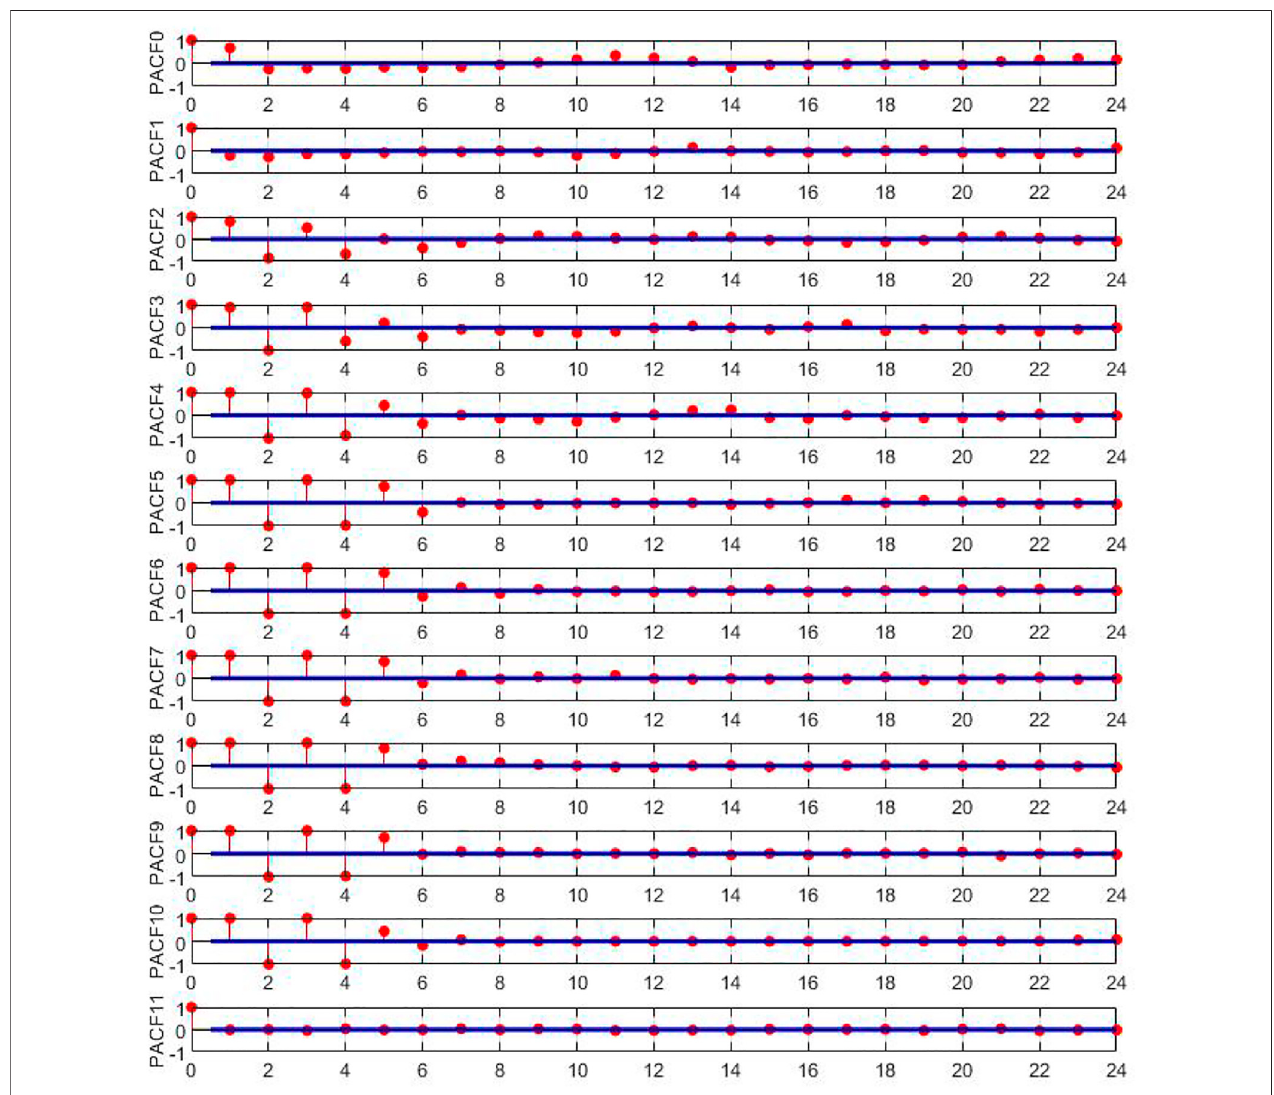
FIGURE 2 | PACF values of each series for the Guangzhao